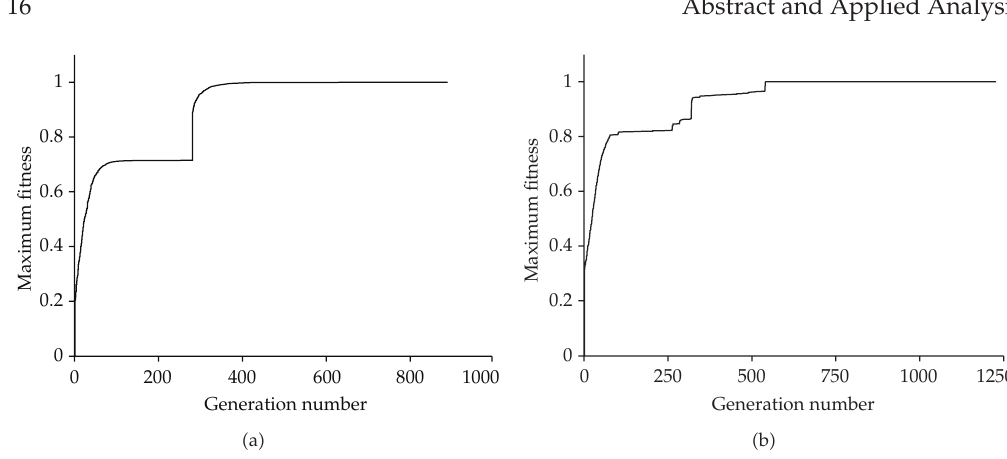
Figure 4: Evolutionary progress plots for the best-of-generation individual for (cid:3) a (cid:4) Problem 1; (cid:3) b (cid:4) Problem 2.